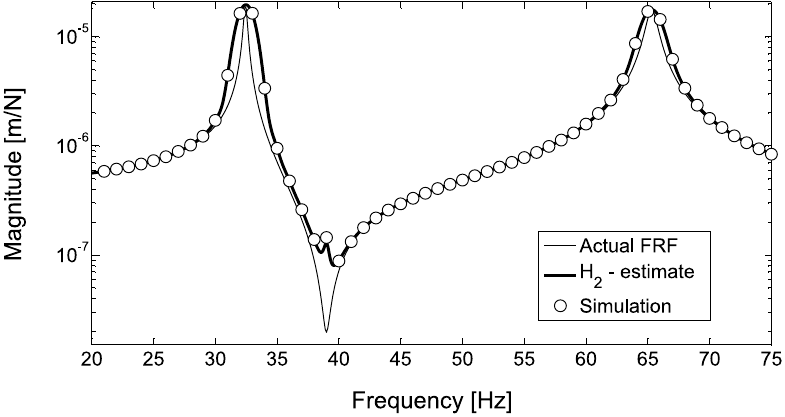
Fig. 3. Based on the same system as in Fig. 2 but the analysis is carried out with the H 2 -formulation. In this case, the estimated FRF over-predicts the true FRF value before and after the resonance and gives a larger bias error at the anti-resonances. The simulation results agrees well with the theoretical biased FRF (-) as given in Eq. (17) for the H 2 -estimate.